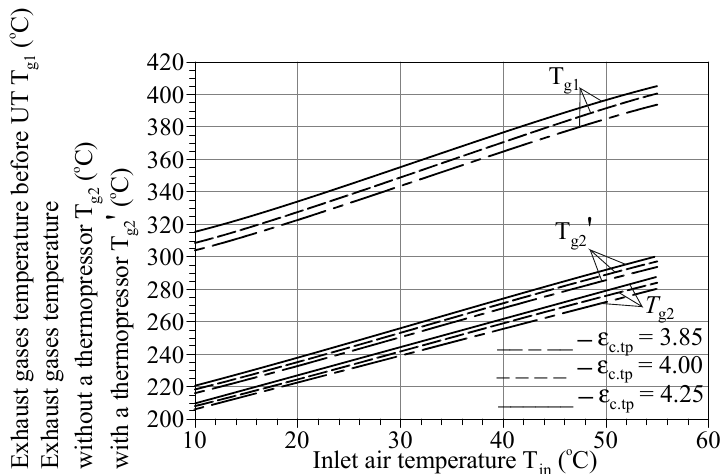
count the energy consumption for the supply of fresh water for injection into the thermo- pressor (Figure 21). According to calculations, the water consumption for injection is G w = 0.6–1.2 kg/s (2.2–4.3 m 3 /h), while the water pump power is N w = 0.3–0.7 kW. The mois- ture content of the air increases by Δ d tp = 40–60 g/kg. Consequently, the power of the in- jection pump is rather small (0.3–0.5%) in comparison with the decrease in the compressor power Δ N c = 100–200 kW.